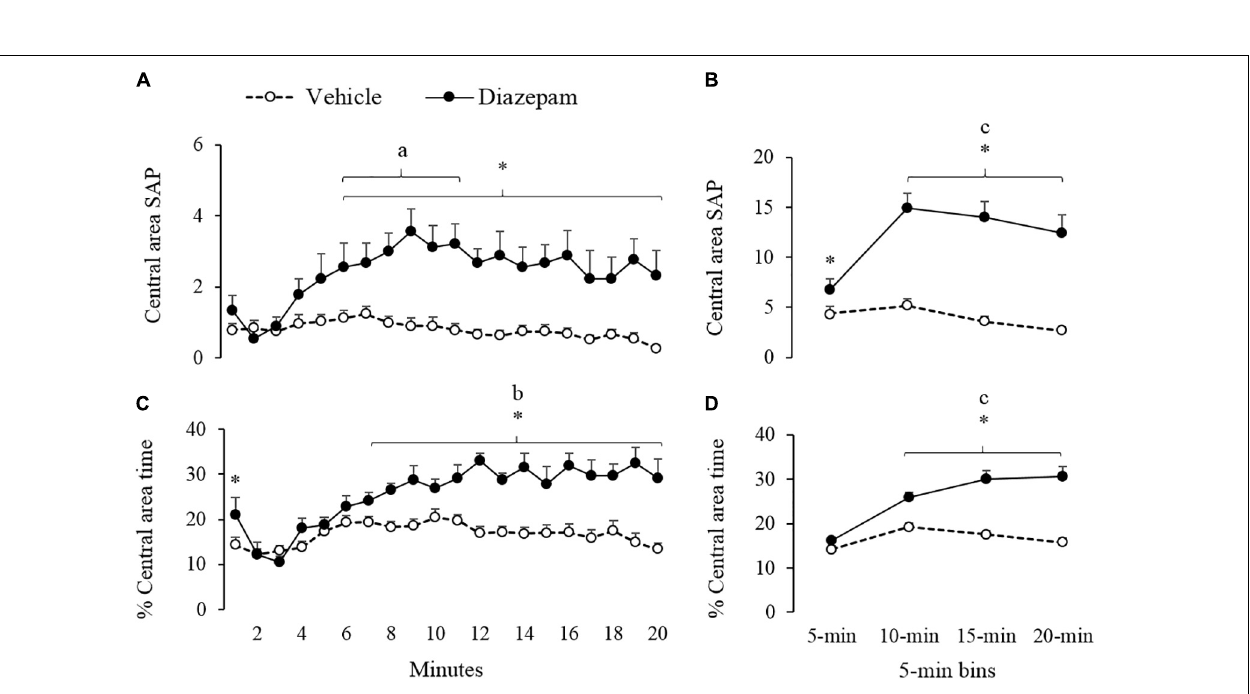
FIGURE 4 | Effect of DZP on risk-assessment behaviors of gerbils exposed to 20-min session in the EPM – i.e., SAP and percentage of time. The left panels show minute-by-minute data (Panel A , C ) and right panels show data in 5-min bins (Panel B , D ). After 5-min of exposure to the EPM, DZP increased the risk-assessment behaviors. a different from the 2nd minute for DZP group, b different from the 2 to 5 min for DZP group, c different from 5-min bin for DZP group, ∗ different from vehicle group ( p <